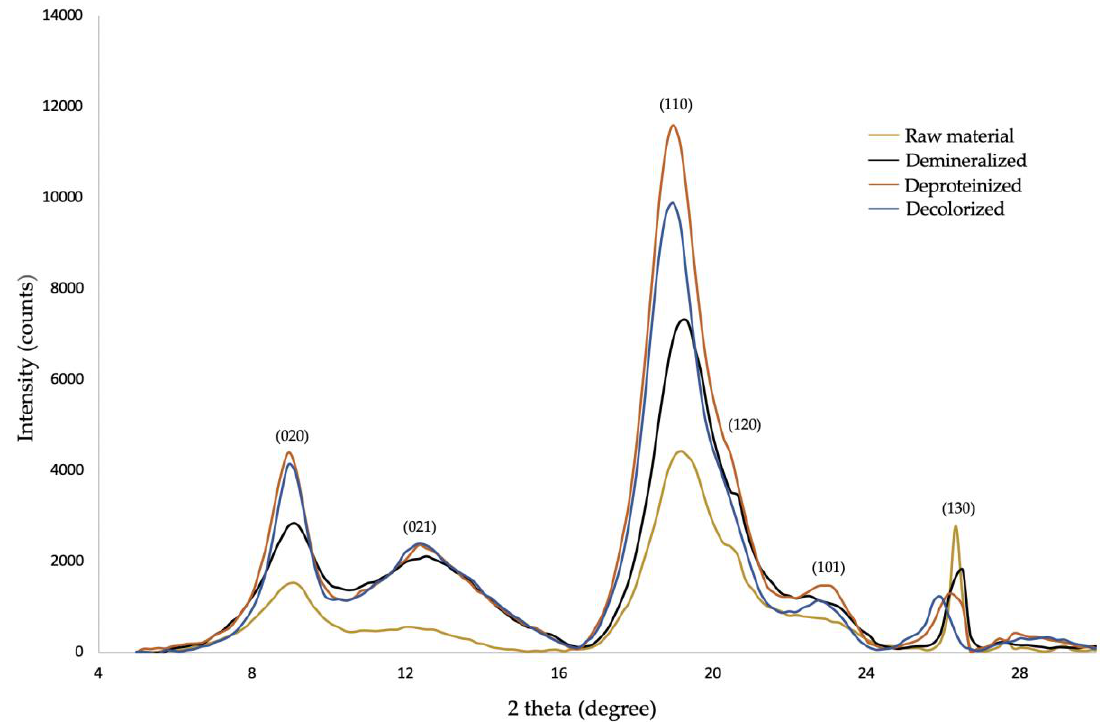
Figure 3. X-ray diffractograms of raw material, demineralized, deproteinized, and decolorized